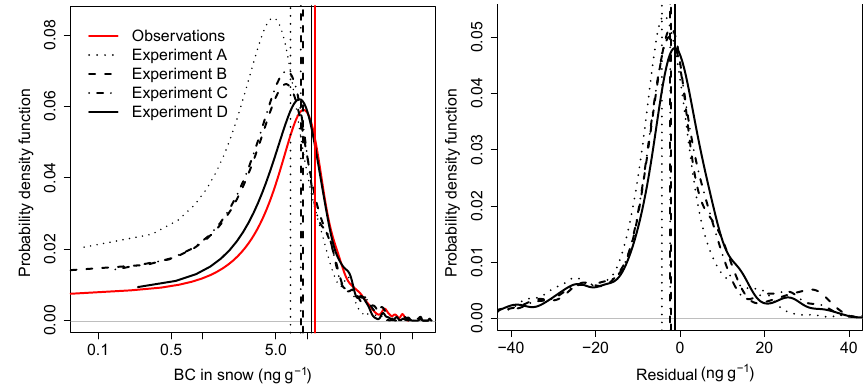
Figure 2. Probability density function of observed (solid red) and GEOS-Chem simulated (black curves: dotted – experiment A; dashed – experiment B; dash dotted – experiment C; solid – experiment D; see Table 2 and text for details) BC concentration in snow (ngg − 1 ) in the Arctic (left panel), medians (vertical lines, left panel), residual errors (model–observation, right panel), and mean residual errors (vertical lines, right panel).